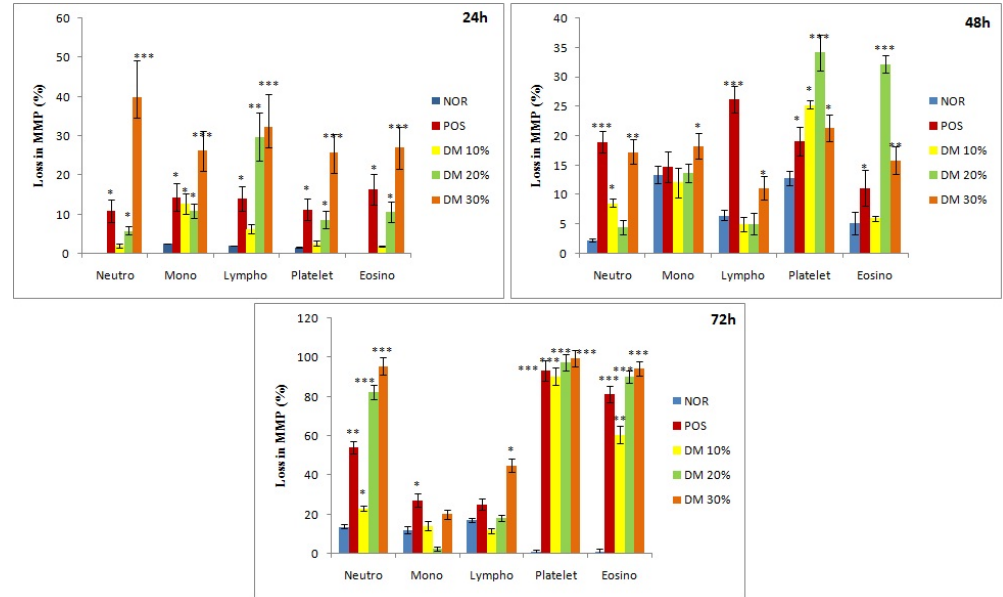
Figure 8. Bar graph representing mean MMP loss in rat WBCs exposed to acute doses of Dimethoate assessed by flow cytometric analysis. * p < 0.05, ** p < 0.01, *** p < 0.001.